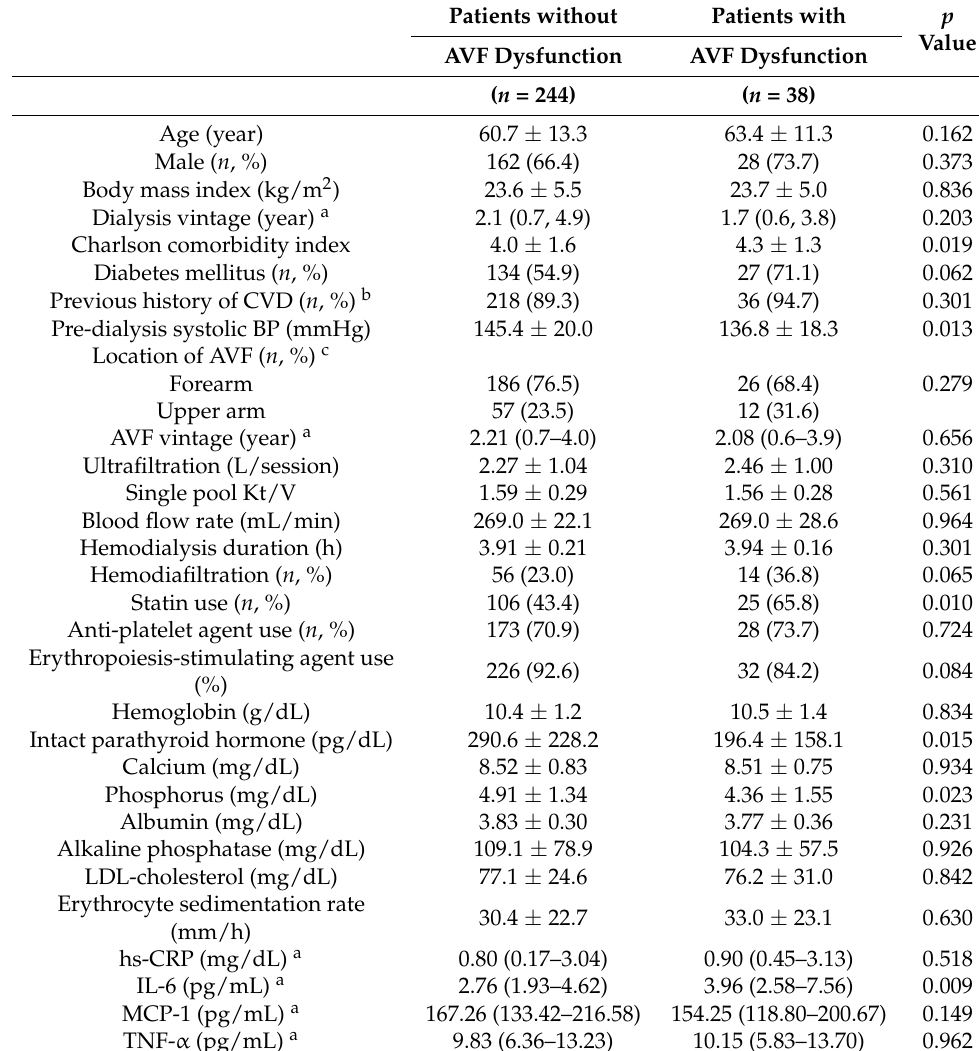
Table 1. Baseline demographic and laboratory data of the study population according to the occur- rence of arteriovenous fistula dysfunction within one year after enrollment. Patients without Patients with